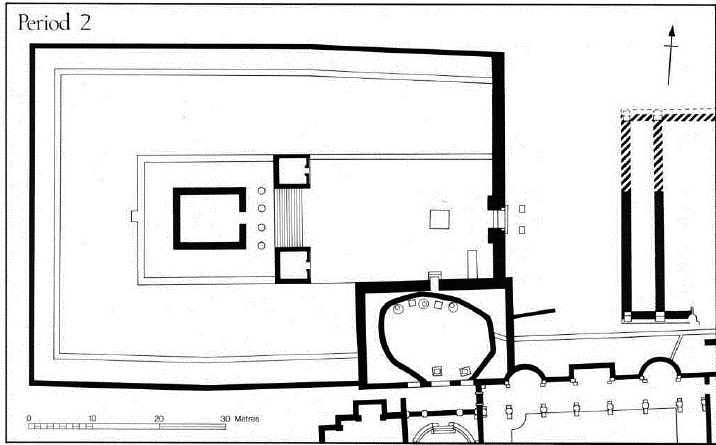
Figure 1: Building phase 2 of the Bath temple complex (Cunliffe and Davenport 1985: